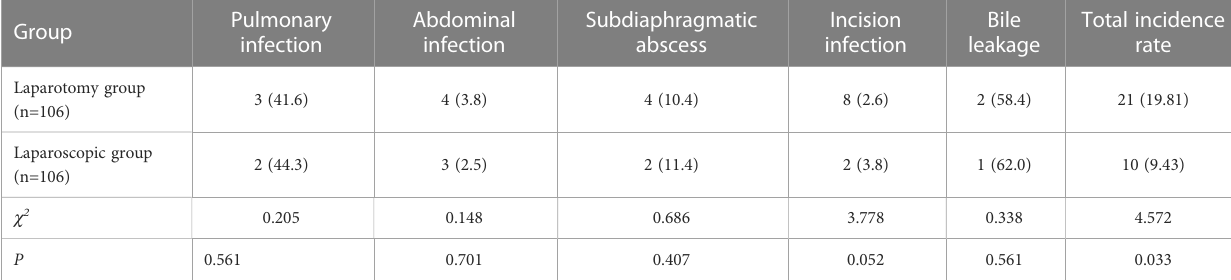
TABLE 3 Comparison of complications between the two groups.